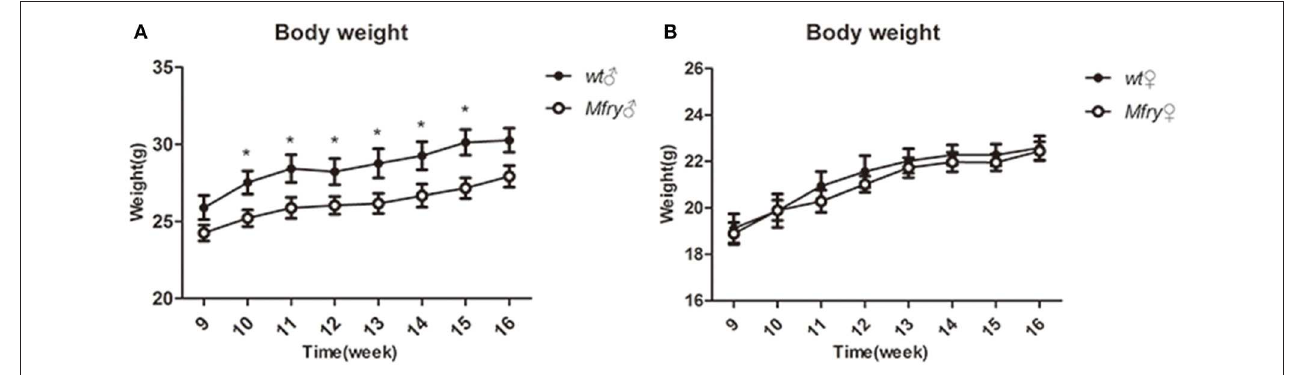
FIGURE 2 | The growth curve of the mice. The body weight of the mice ( n = 5 for male and female WT mice, n = 7 for male and female Mfry mice) from 9 weeks to 16 weeks was measured. (A) Male mice body weight between Mfry and WT. (B) Female mice body weight between Mfry and WT. Female mice show no difference between Mfry and WT mice. Male Mfry mice show the growth retardation when compare with WT male mice. Values are presented as means ± SEM. * P < 0.05. Mfry vs.